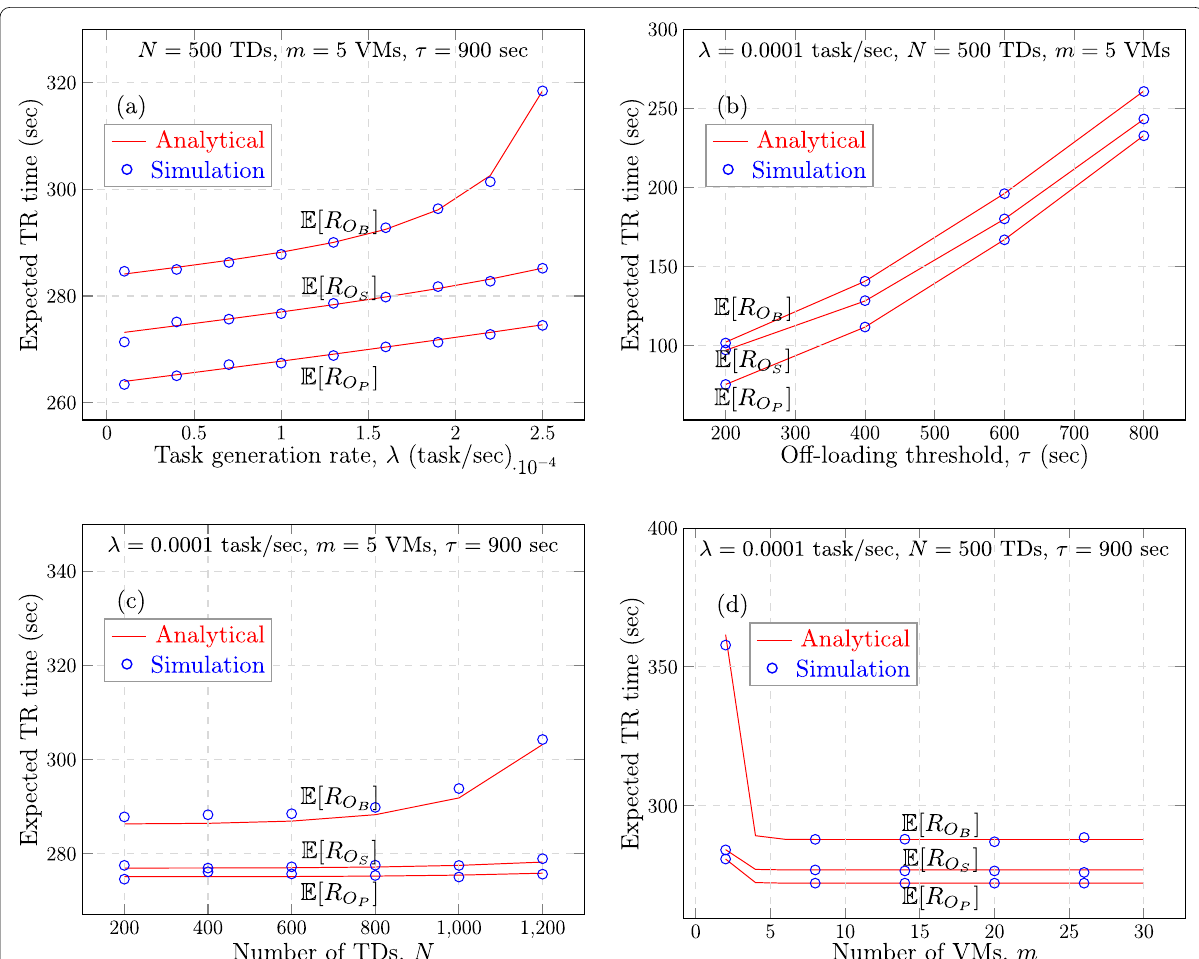
Fig. 7 Comparison of the overall TR times for perfect, semiperfect and baseline modes, E [ R O P ] represented in (28), E [ R O S ] represented in (29) and E [ R O ] represented in (30) where μ B